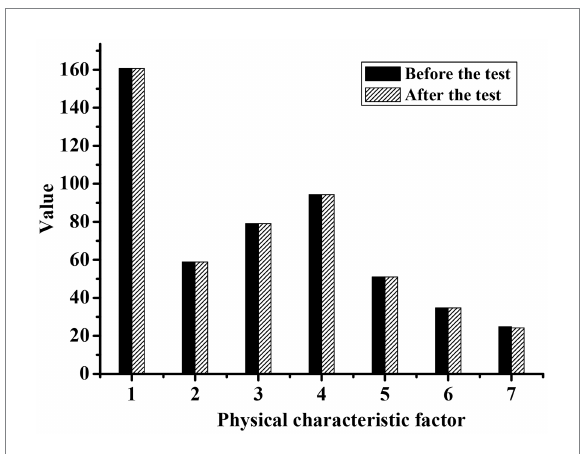
FIGURE 2 Comparison of physical characteristics index values of silver- haired people in the control group before and after the experiment. (1: height; 2: weight; 3: waist circumference; 4: hip circumference; 5: thigh circumference; 6: calf circumference; 7: forearm circumference).